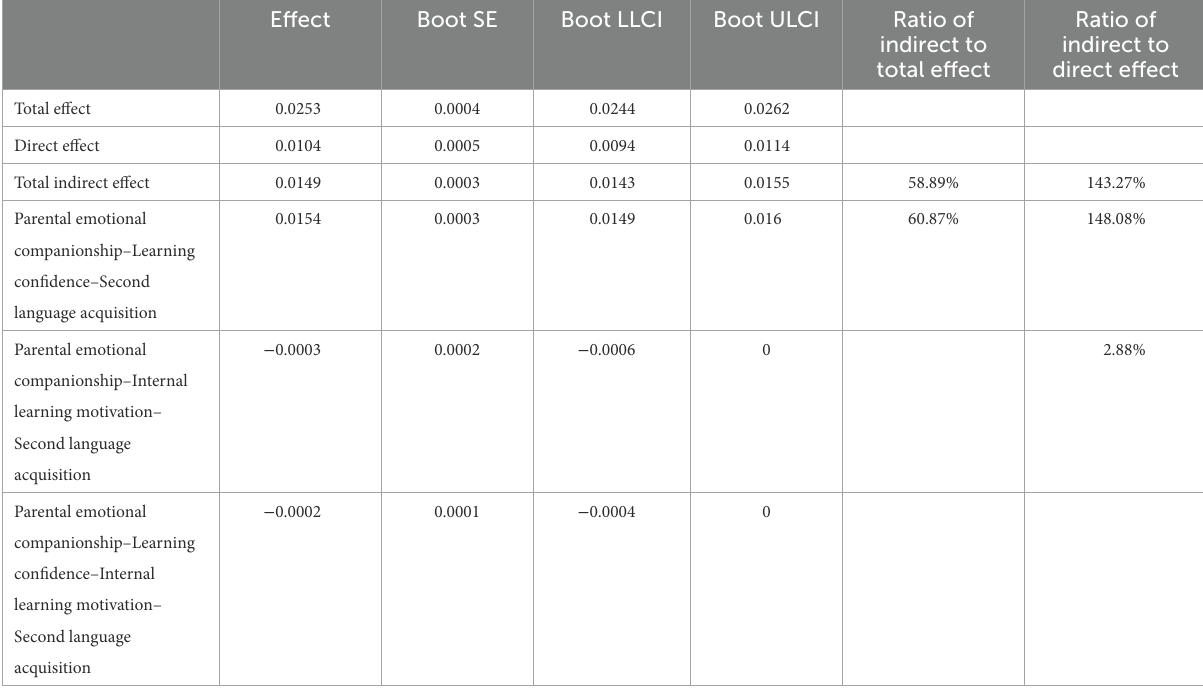
TABLE 6 Results of Bootstrap test of mediating effect in middle school